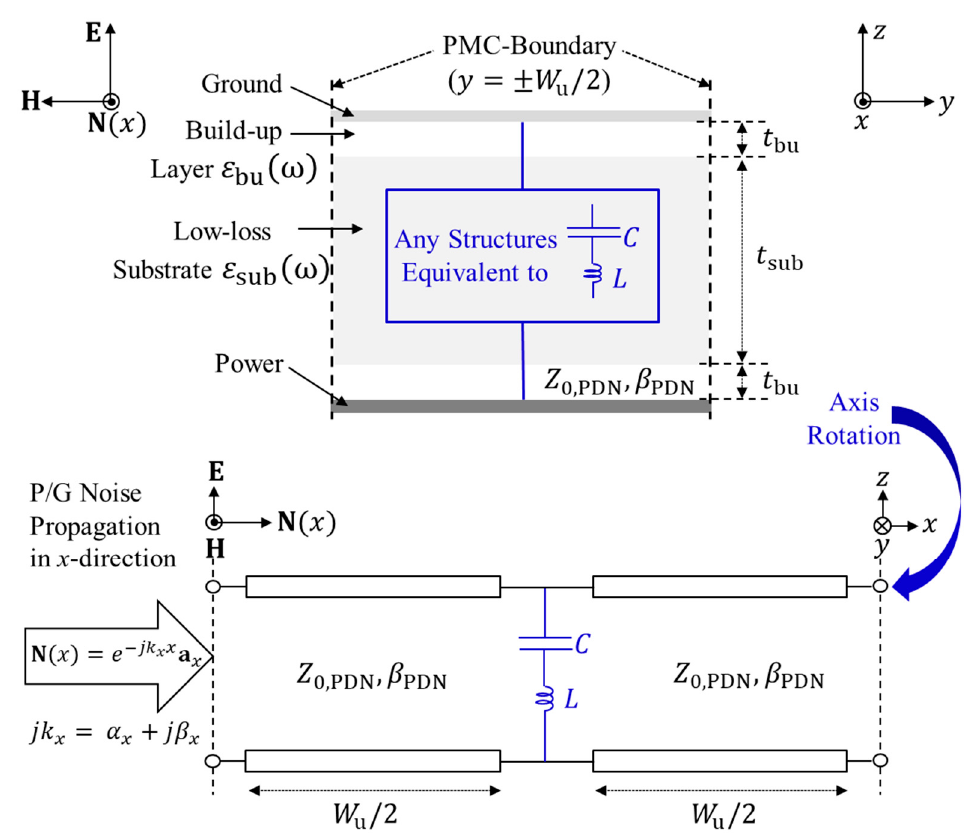
Figure 3. One-dimensional equivalent circuit model of the PDN with structure generating C and L .